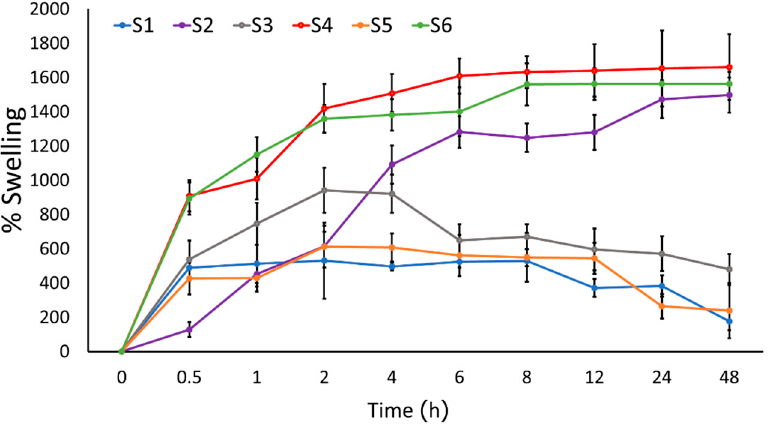
Figure 1. Swelling profiles of the sericin hydrogel formulations S1–S6 in PBS pH 7.4 ( n = 3).